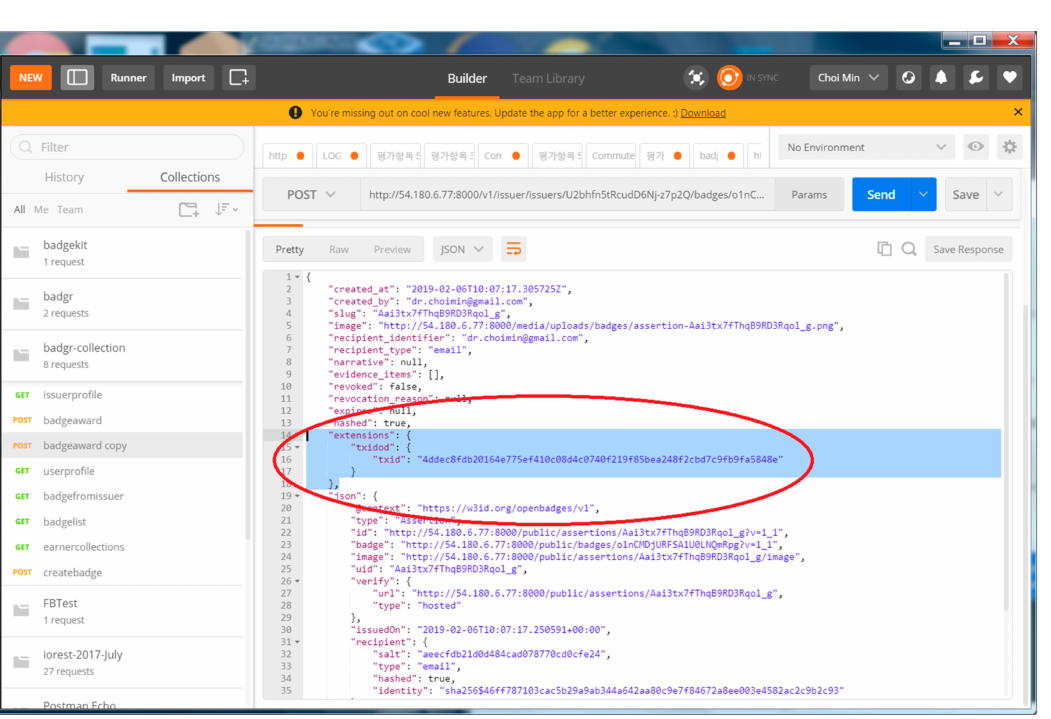
Figure 19. Extension field in result returned as JSON to digital badge award by REST